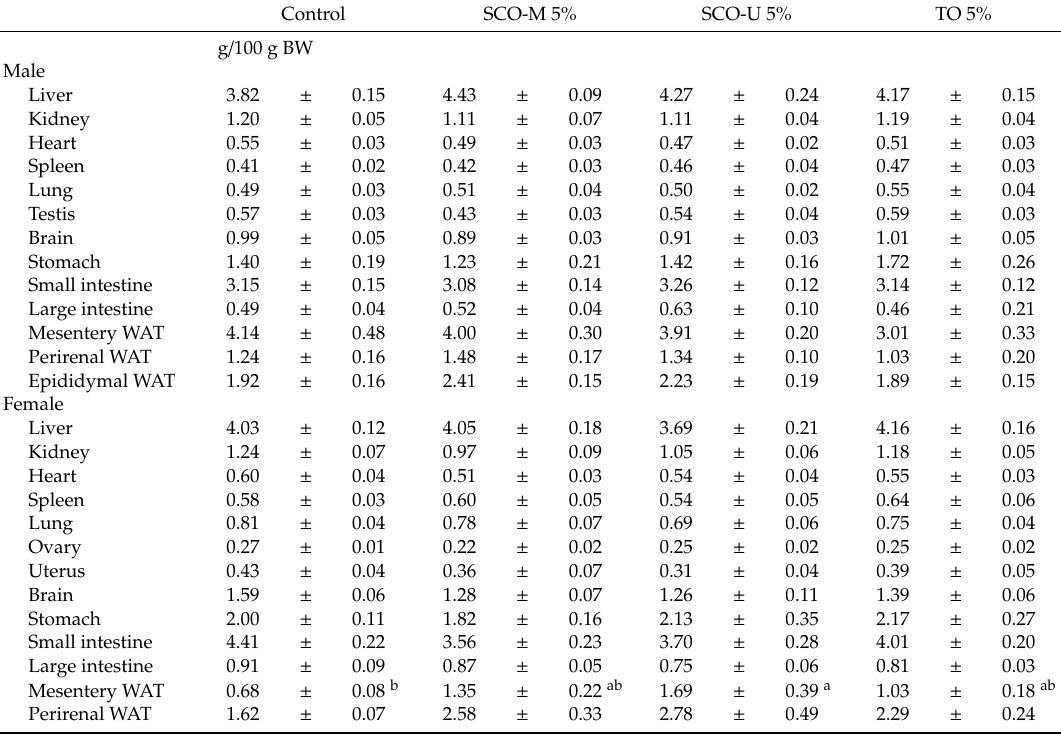
Table 3. Organ weights of mice administered with scallop oil for 13